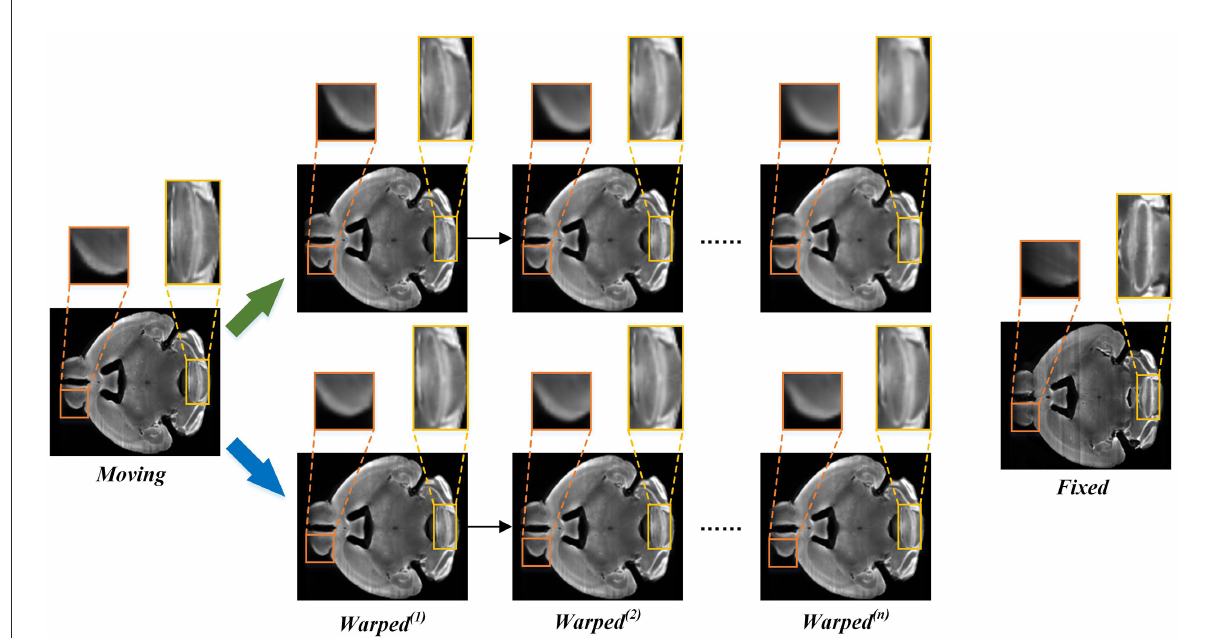
FIGURE7 The intermediate registration results generated by our method and conventional cascade registration methods with information loss in the iterative process. The green arrow points to the iterative registration process of the conventional recursive cascade method with information loss, and the blue arrow points to the iterative registration process of our